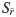
Technical procedure to locate the threshold value minimizing the RMSD.Upper Panel: RMSD of the sets Sr¯ for different values of r¯. The minimum of the RMSD is obtained for r¯=0.3 (point E). In green we show the four-degree polynomial fitting the RMSD, with standard deviation SD. The RMSD values falling below the minimum of such polynomial plus SD (green area) are plausible RMSD minima (highlighted in black). We fit these plausible RMSD minima by a second-degree polynomial (yellow curve). The argument of the minimum of such polynomial is considered as the putative value minimizing the RMSD. Panel A: sets Sr¯ for r¯=0.6. Panel B: same as A for r¯=0.5. Panel C: same as A for r¯=0.4. Panel D: same as A for r¯=0.35. Panel E: same as A for r¯=0.3. Panel F: same as A for r¯=0.25. The Sset here is well fitted by a straight line, while the others show a curvature.